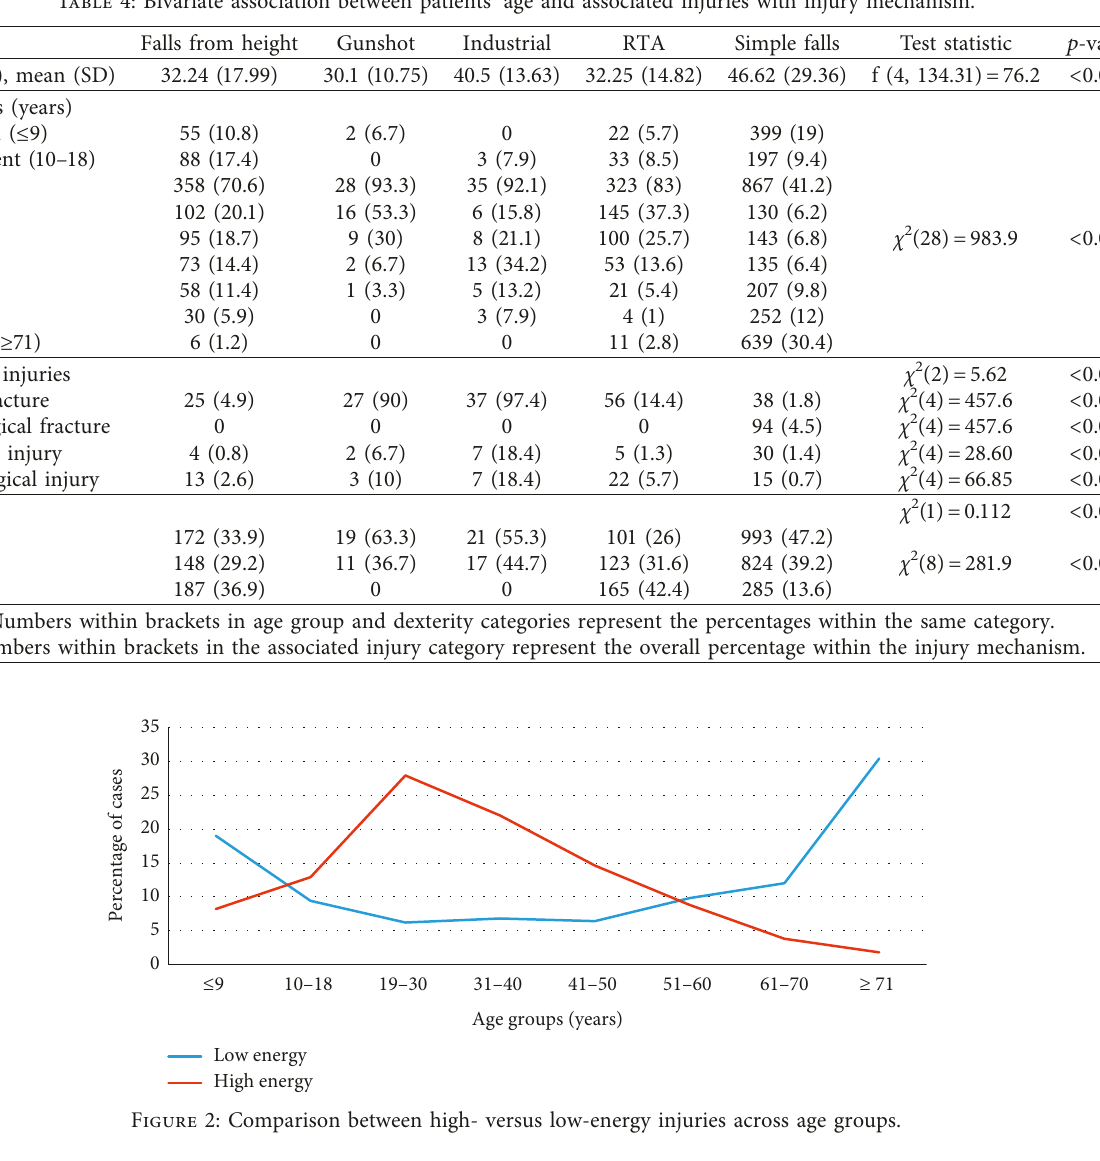
Table 4: Bivariate association between patients’ age and associated injuries with injury mechanism.